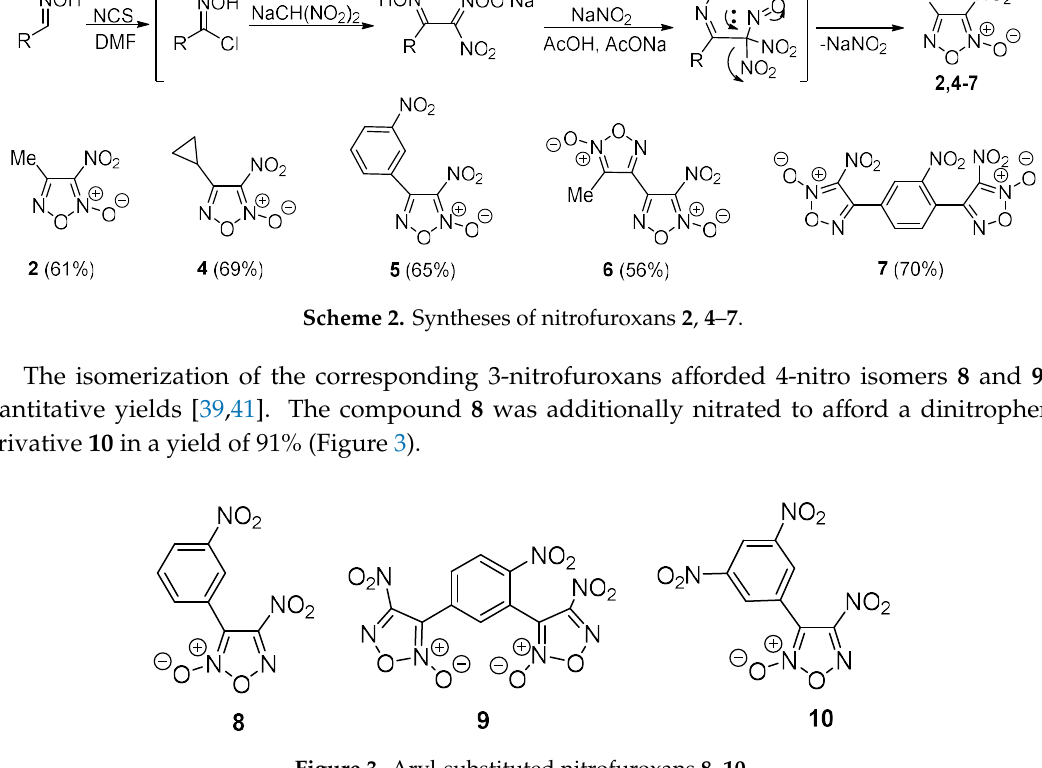
Figure 3. Aryl-substituted nitrofuroxans 8 – 10